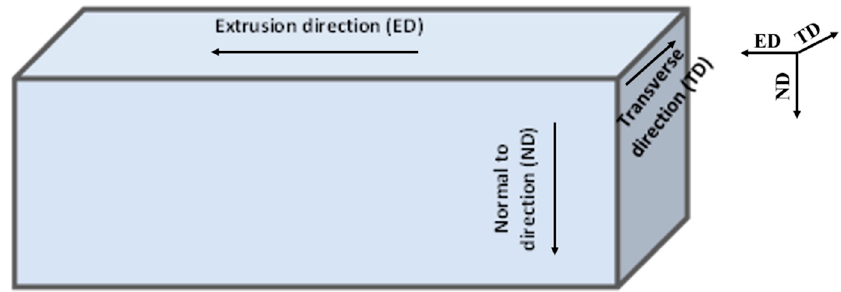
Figure 1. Schematic depiction of different orientations (ED, ND and TD) with respect to the extrusion direction of a ZK60 extruded bar.